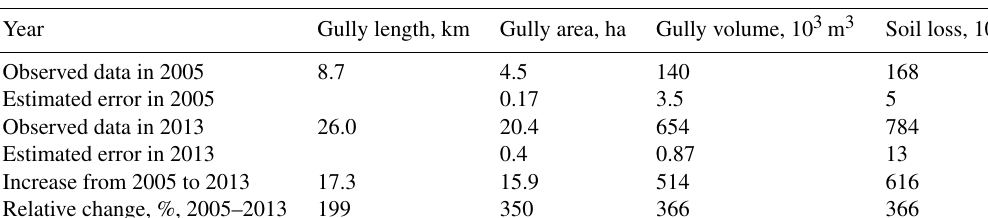
Table 1. The combined length, area, and volume of the total gully network in the 608ha Debre Mawi watershed obtained from satellite imagery in 2005 and 2013. The “soil loss” in the last column represents the total soil loss from the gully network preceding the date of measurements and is calculated as the gully volume in the fourth column times the bulk density. Errors were estimated using Eqs. (8) and (9).